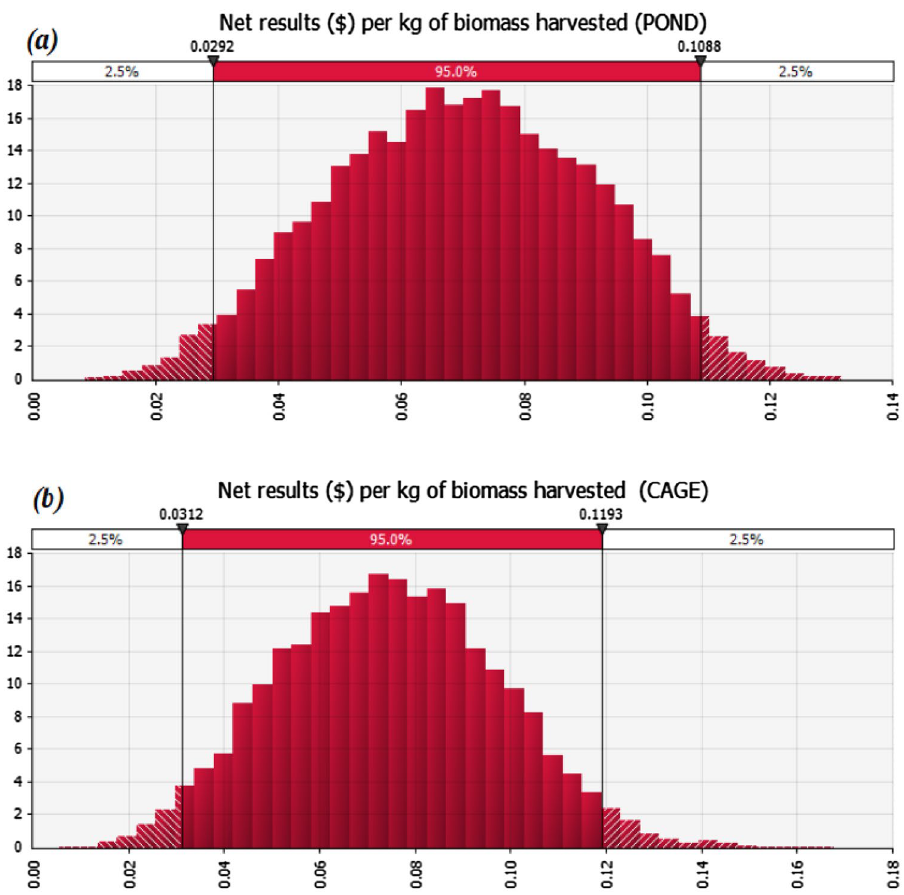
Figure 1. Probability distribution of net result per kg of biomass harvested for ( a ) pond scenario and ( b ) cage scenario. The histogram shows the range of possible outcomes (x-axis) and their relative likelihood of occurrence